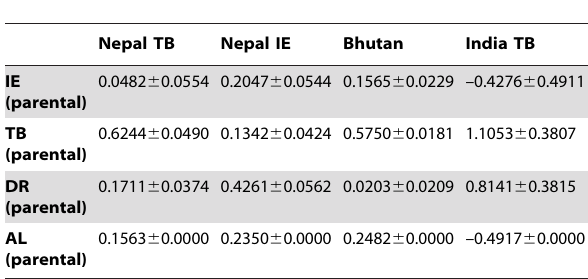
Table 2. Summary of Admixture